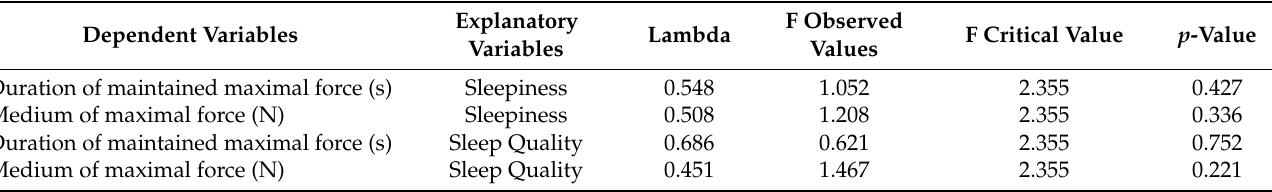
Table 22. Parameter values of the Wilks lambda